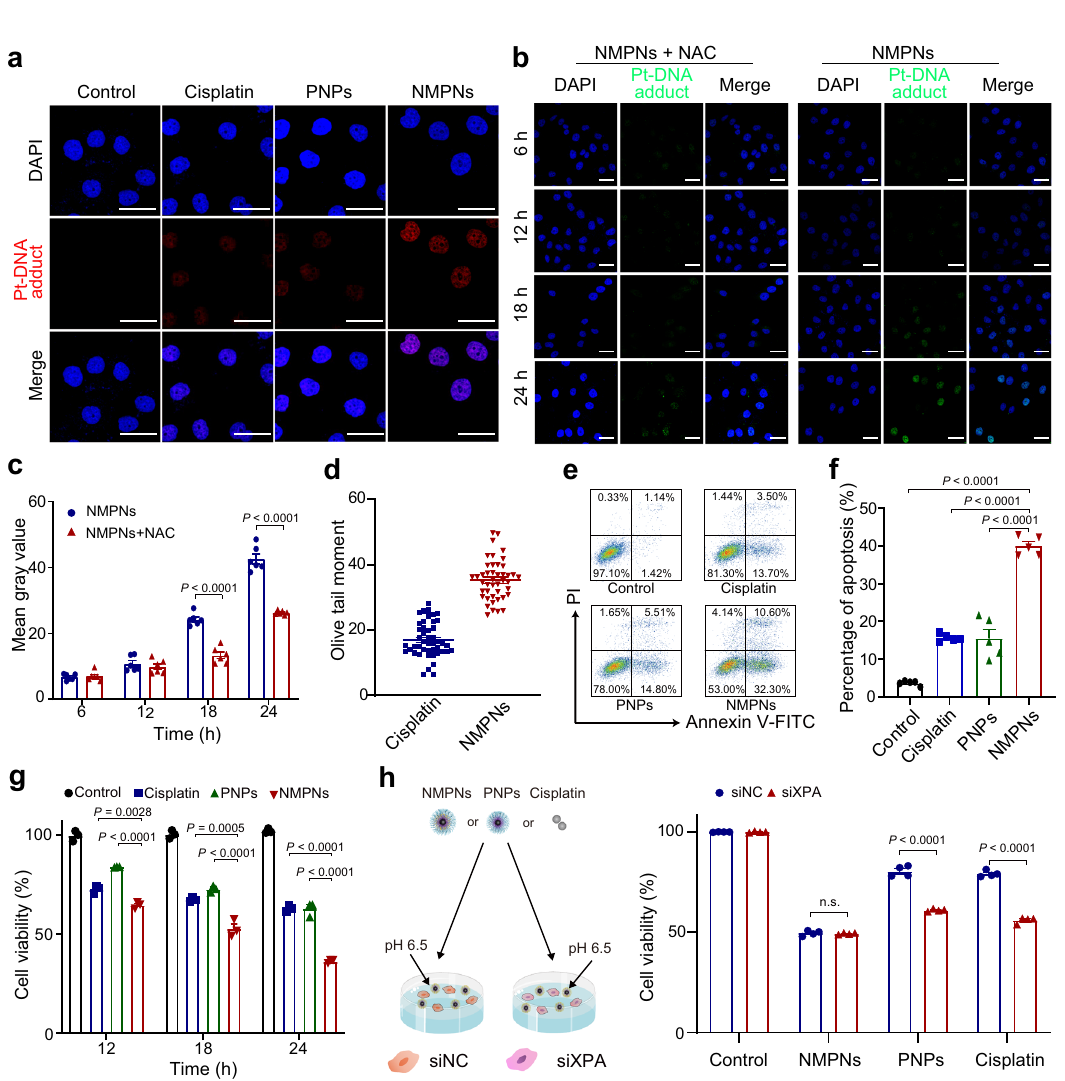
Fig. 6 | NMPNs promote cisplatin-resistant tumour cell apoptosis by inducing Pt-DNA adducts without NER repairing. a Immuno fl uorescence of the Pt-DNA adducts in cisplatin-resistant Huh7 cells after different treatments at pH 6.5. Scale bar: 40 μ m. b Immuno fl uorescence of the Pt-DNA adducts in cisplatin-resistant Huh7 cells after treatments with NMPNs or NMPNs+NAC at different time points. Scale bar: 40 μ m. c Quantitative analysis of Pt-DNA adducts in cisplatin-resistant Huh7 cells after treatments with NMPNs or NMPNs+NAC at different time points. n =6independentexperiments. d QuantitativeanalysisofDNAdamageofcisplatin- resistant Huh7 cells after treatment with cisplatin or NMPNs. Cisplatin: n =46;